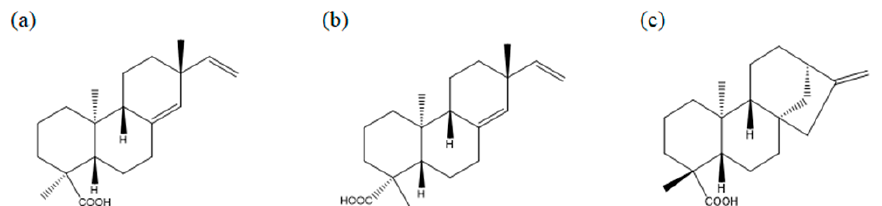
Figure 2. Identification of three diterpenes from the extract of A. continentalis . A chemical formula for ( a ) epi -continentalic acid ( ent -pimara-8(14),15-dien-18-oic acid), ( b ) continentalic acid ( ent -pimara-8(14),15-dien-19-oic acid), and ( c ) kaurenoic acid ( ent -kaura-16-en-19-oic acid) is C 20 H 30 O 2 , C 20 H 30 O 2 , and C 20 H 30 O 2 , respectively.